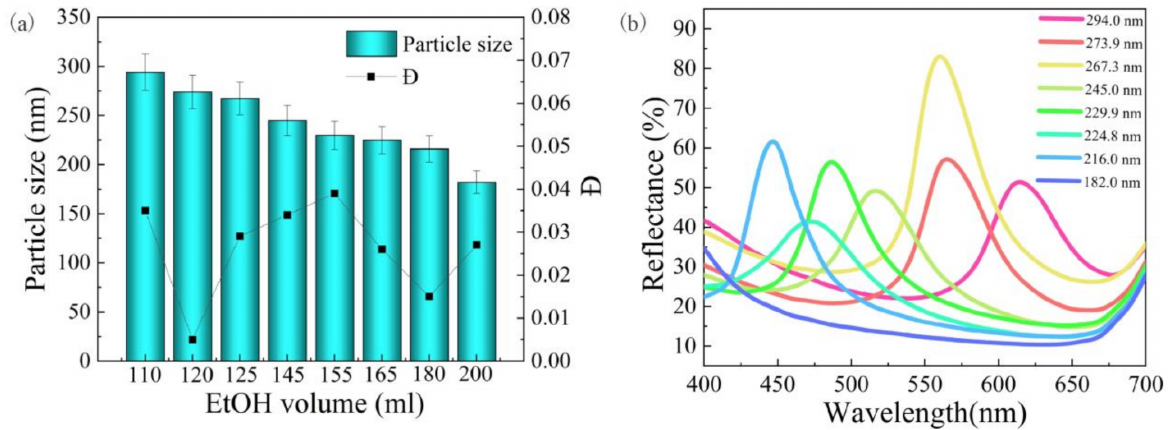
Figure 1. ( a ) Different mean SiO 2 NPs sizes: 294.0, 273.9, 267.3, 245.0, 229.9, 224.8, 216.0 and 182.0 nm with different Ð values as a function of EtOH amount: 100, 120, 125, 145, 155, 165, 180 and 200 mL respectively. ( b ) The reflectance spectra of SiO 2 PCFs that were constructed by self-assembled SiO 2 NPs with controllable sizes in visible light